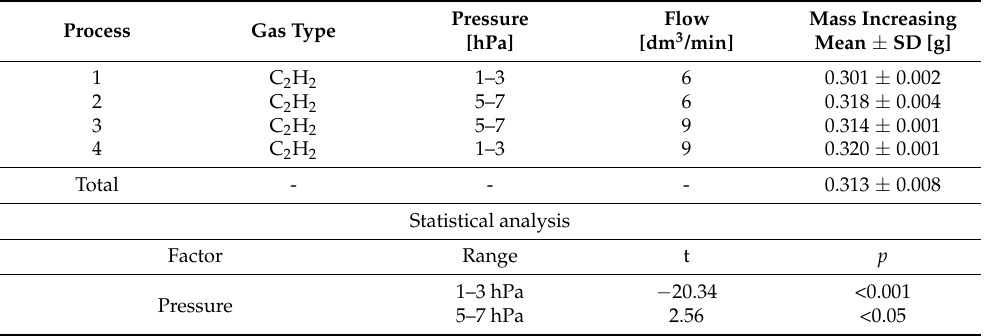
Table 2. The mass of carbon introduced into the surface layer in low-pressure carburising processes using acetylene.